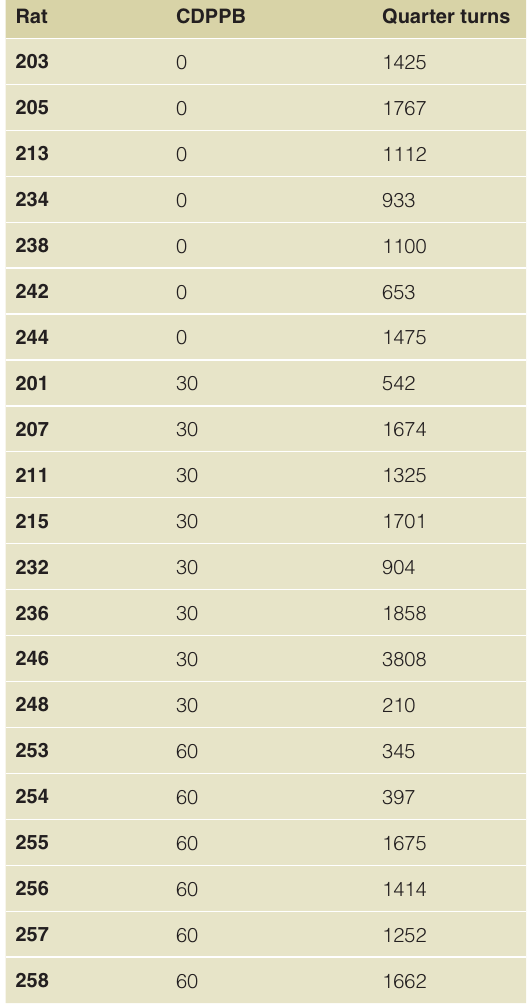
Table S6. CDPPB effects on METH locomotor response (total quarter turns over 90 min) – rats with histories of METH injections. In the Day 16 tests using 0.5 mg/kg METH in all groups, rats with a history of chronic METH exposure exhibited elevated locomotor behavior, but CDPPB pretreatment had no